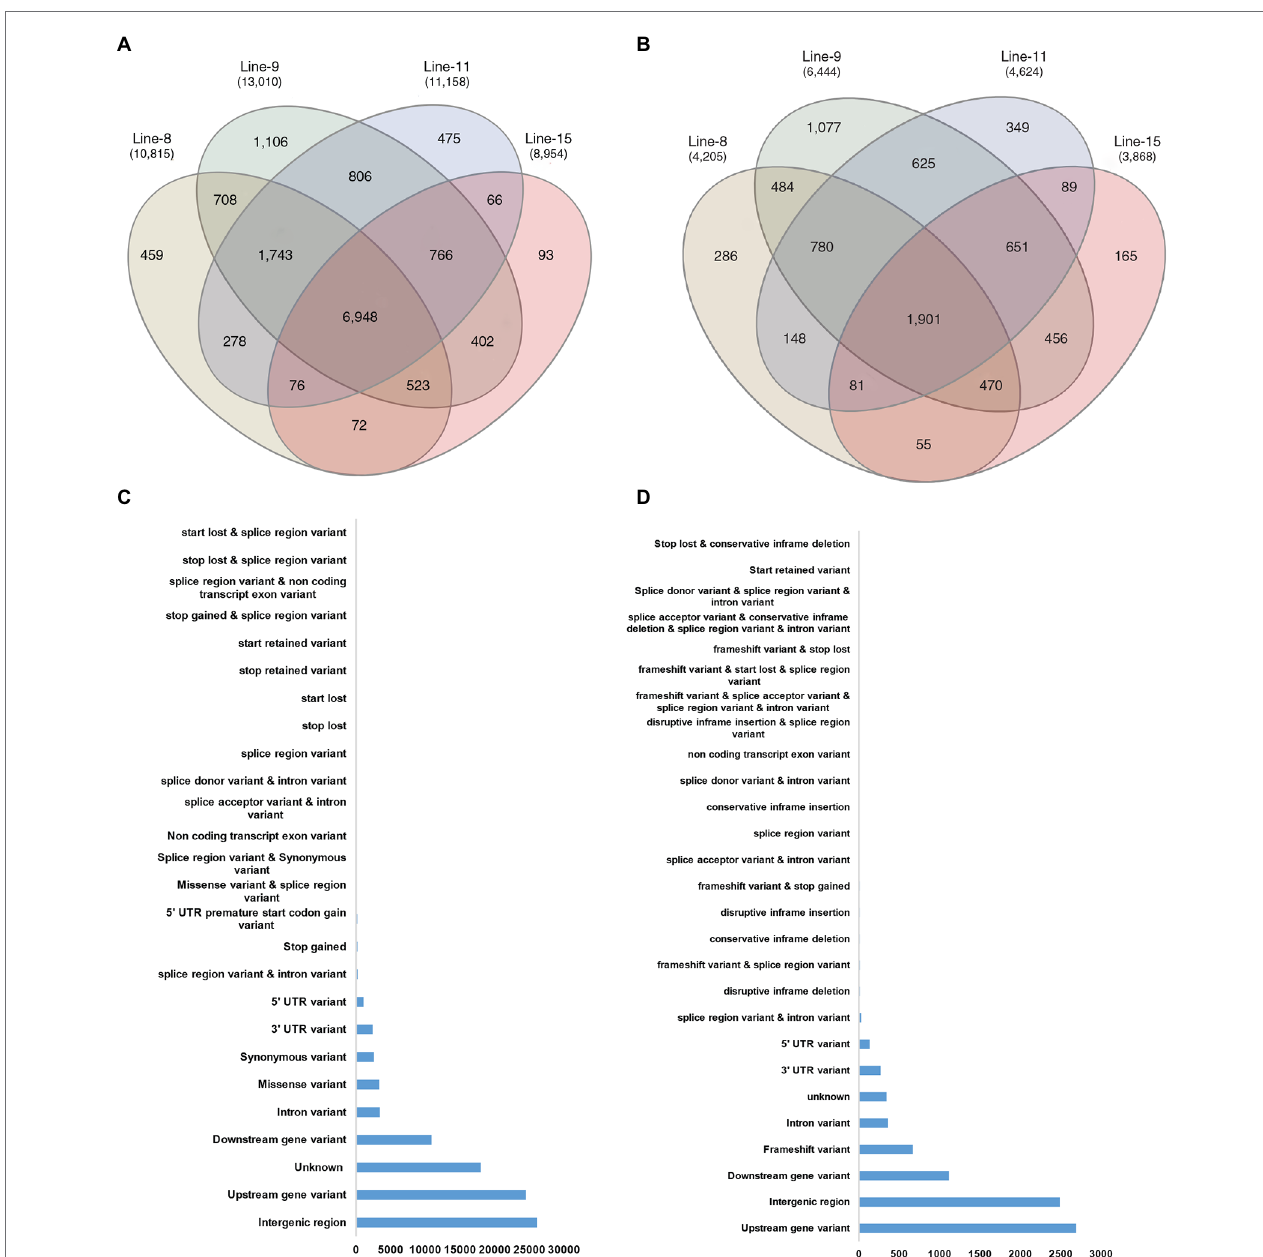
FIGURE 5 | Common genes affected by SNPs and InDels in all mutant lines; (A) Venn diagram depicting common genes affected by SNP variants in mutant lines; (B) Common genes affected by InDel variants in mutant lines; (C) Annotation by location of common SNP variants at common genomic locations in all mutant lines; and (D) Annotation by location of common InDel variants at common genomic locations in all mutant